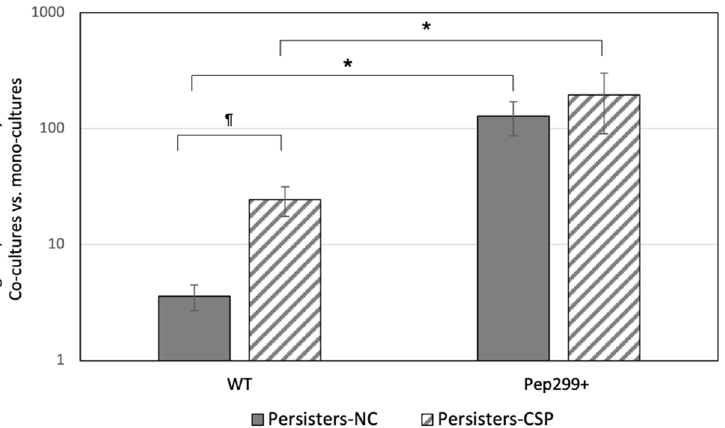
Figure 4. Effect of pep299 on persister formation by neighboring ∆ 299 mutant cells. ∆ 299 mutant was co-cultivated for 2 h with a S. mutans wild-type strain harboring an empty plasmid (WT) or a ∆ 299-overexpressing mutant (Pep299+) in the presence (‘persisters-CSP’) or absence (‘persisters-NC’) of CSP. The co-cultures were then treated with ofloxacin for 24 h to kill all nonpersisters. Monocultures of ∆ 299 mutant were used as a control. Aliquots of cells were removed at the introduction of the antibiotic (T = 0) and after the antibiotic treatment (T = 24). Samples were washed with PBS, serially diluted, and spot-plated onto THYE agar for CFU determination. The data are the average of three independent experiments ± standard error. ¶ denotes statistically significant difference between WT ‘persisters-CSP’ vs. WT ‘persisters-NC’. * denotes statistically significant difference between Pep299+ vs. WT under the same